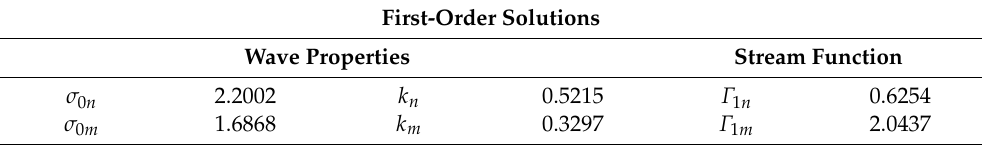
Table 2. Relevant coefficients for the first-order example.